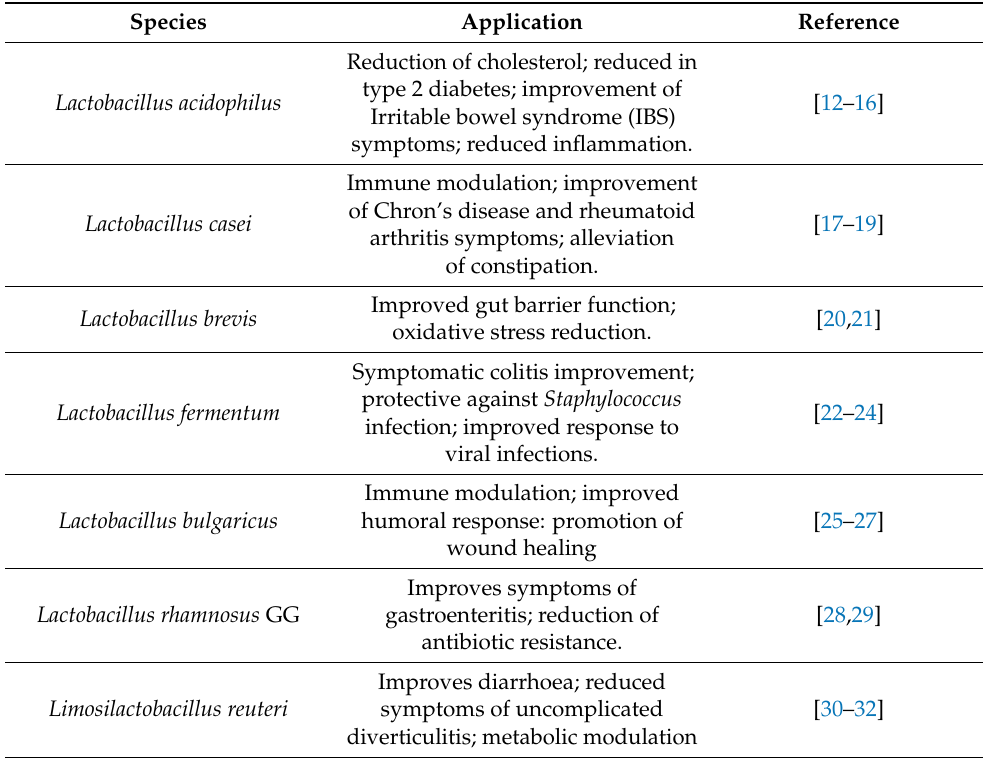
Table 1. Lactobacilli and their effect on human